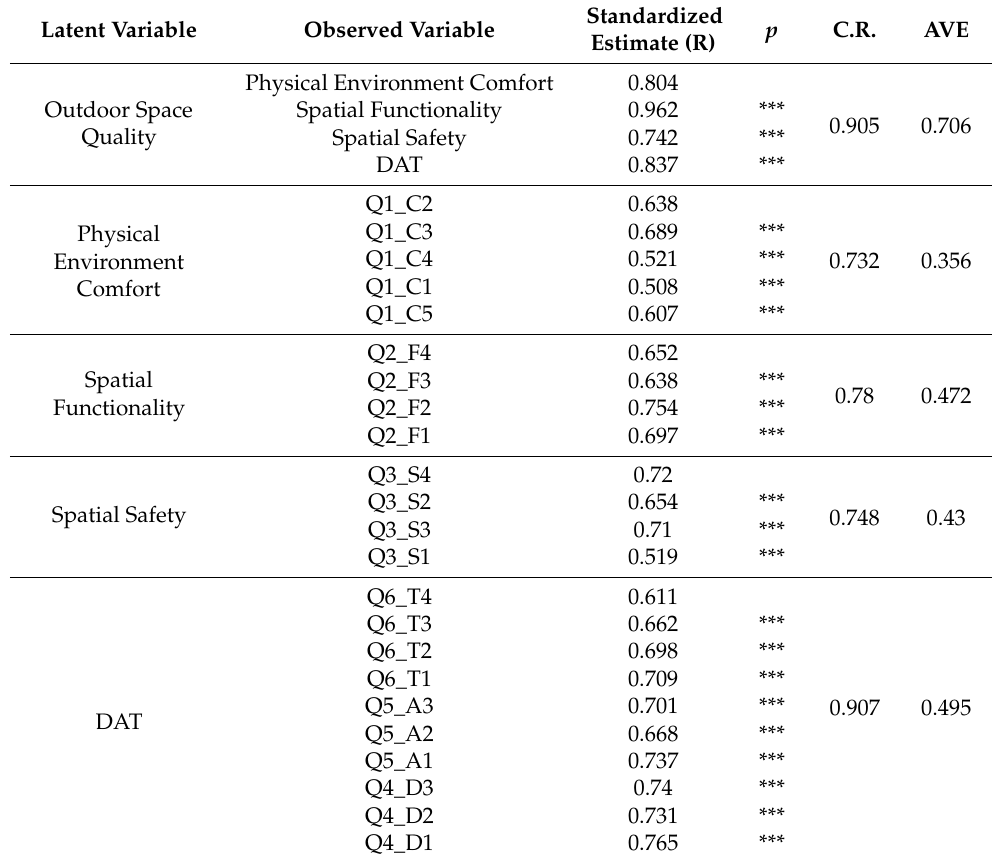
Table 6. Measurement model validity